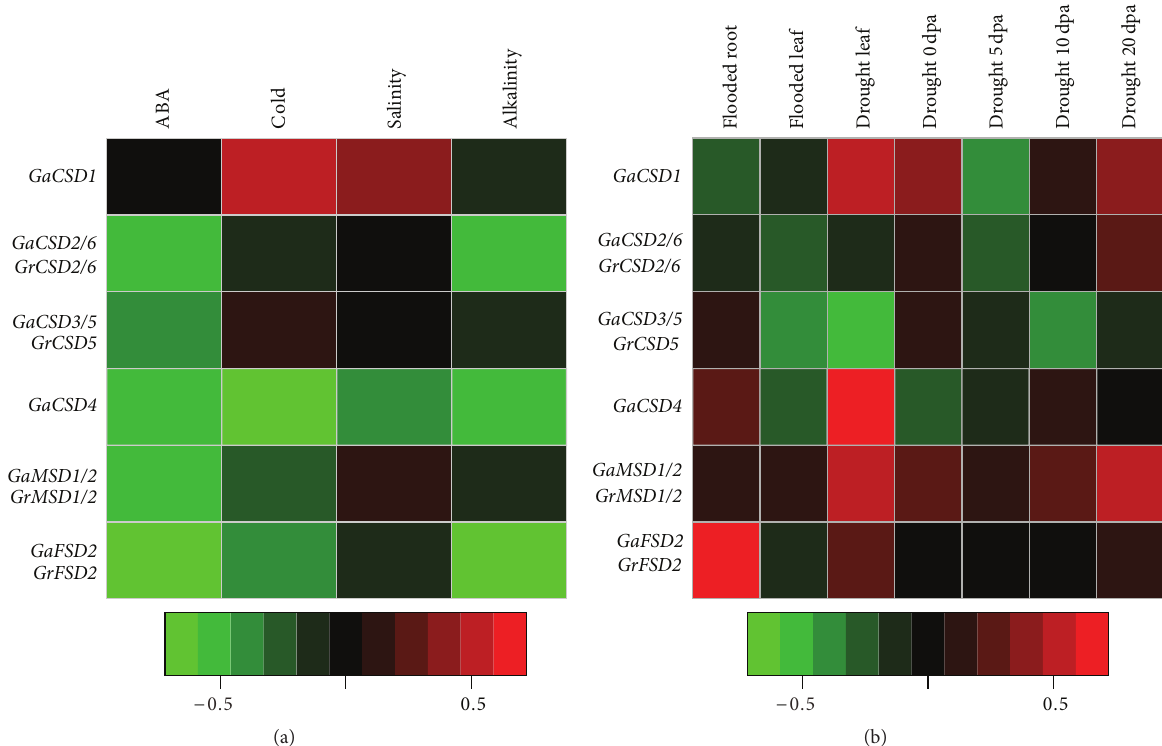
Figure 4: Expression profiles of cotton SOD genes under abiotic stress. (a) Expression patterns under cold, salinity, ABA, and alkalinity stresses (GSE50770) in cotton seedlings with different abiotic stresses treatment were selected at 14-day after germination. (b) Expression profiles in G. hirsutum roots and leaves under waterlog stress (GSE16467) and microarray expression data for leaf and fiber development stages (0, 5, 10, and 20 dpa) under drought stress (GSE29567 and GSE29810).